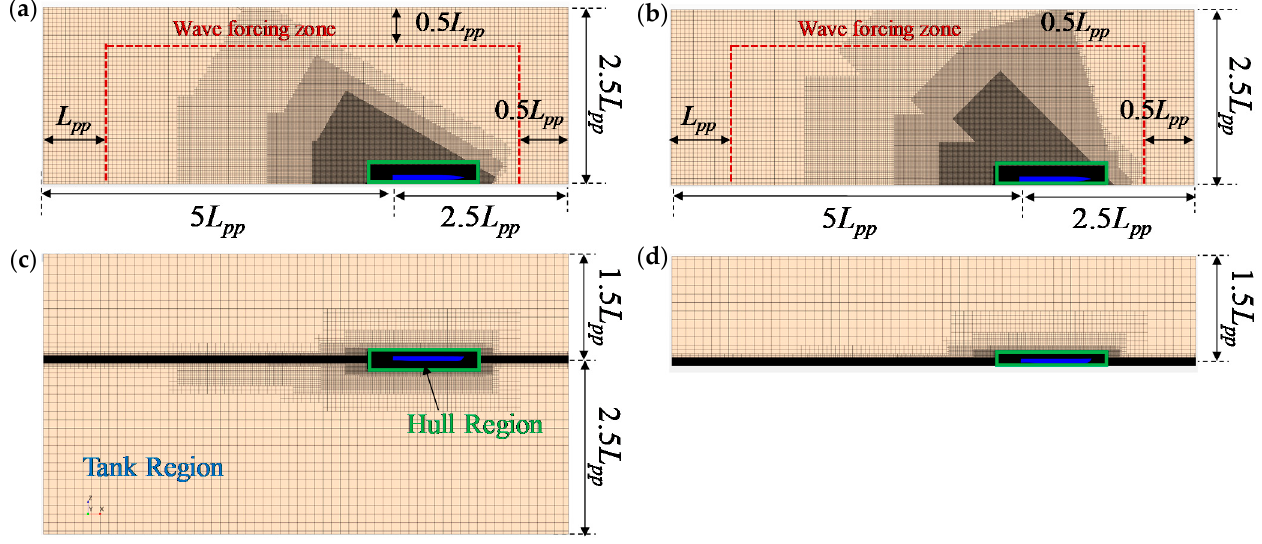
Figure 2. Computational meshes and domain dimensions used for deep water ( a , c ) and shallow water cases ( b , d ).